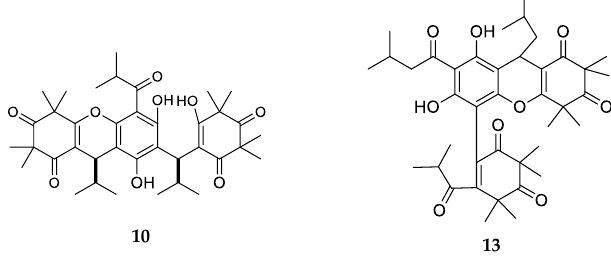
Figure 4. Structures of compounds of the trimeric-monopyrane-type.